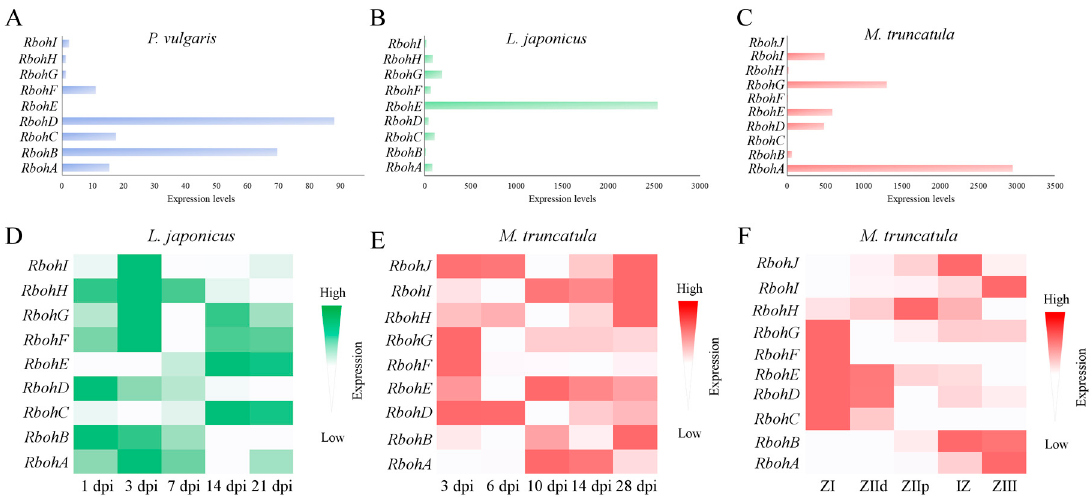
Figure 3. Expression profiles of nodule-expressed Rbohs in legumes. ( A – C ), Expression levels of Rboh s in nodules of P. vulgaris ( A ), L. japonicus ( B ), and M. truncatula ( C ) at 21 dpi ( A , B ) and 28 dpi ( C ) [38,40,41]. Heatmap showing expression of Rboh s from L. japonicus ( D ) and M. truncatula ( E ) in roots (1–7 dpi) and nodules (10–28 dpi) following inoculation with Rhizobium . Heatmap showing MtRboh expression in different zones of M. truncatula nodules at 15 dpi with Sinorhizobium meliloti ( F ). ZI, meristematic zone; ZII, infection zone; IZ, interzone; and ZIII, nitrogen-fixing zone [3]. In the region where rhizobia are released from the infection threads of M. truncatula nodules (ZIIp), MtRbohH is most strongly expressed, while transcripts of MtRbohB and MtRbohJ are mainly